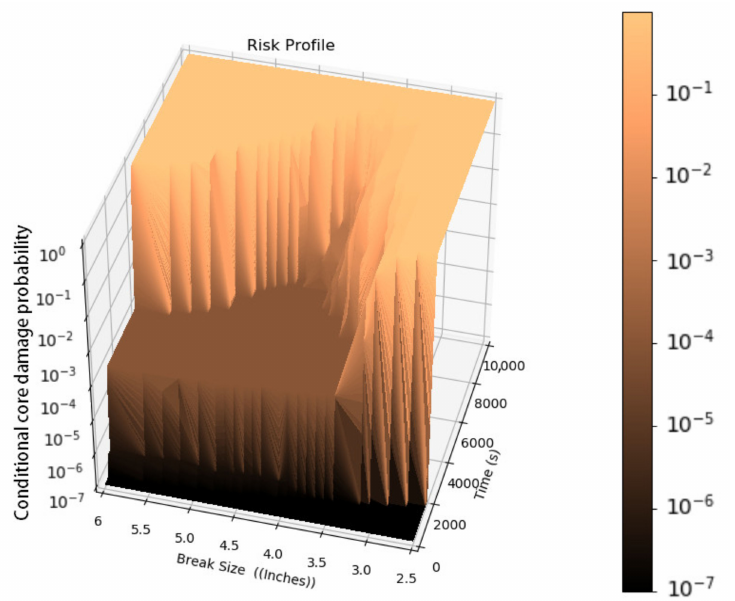
Figure 10. Coping time response surface for SiC with a fine grid of break size (0.1